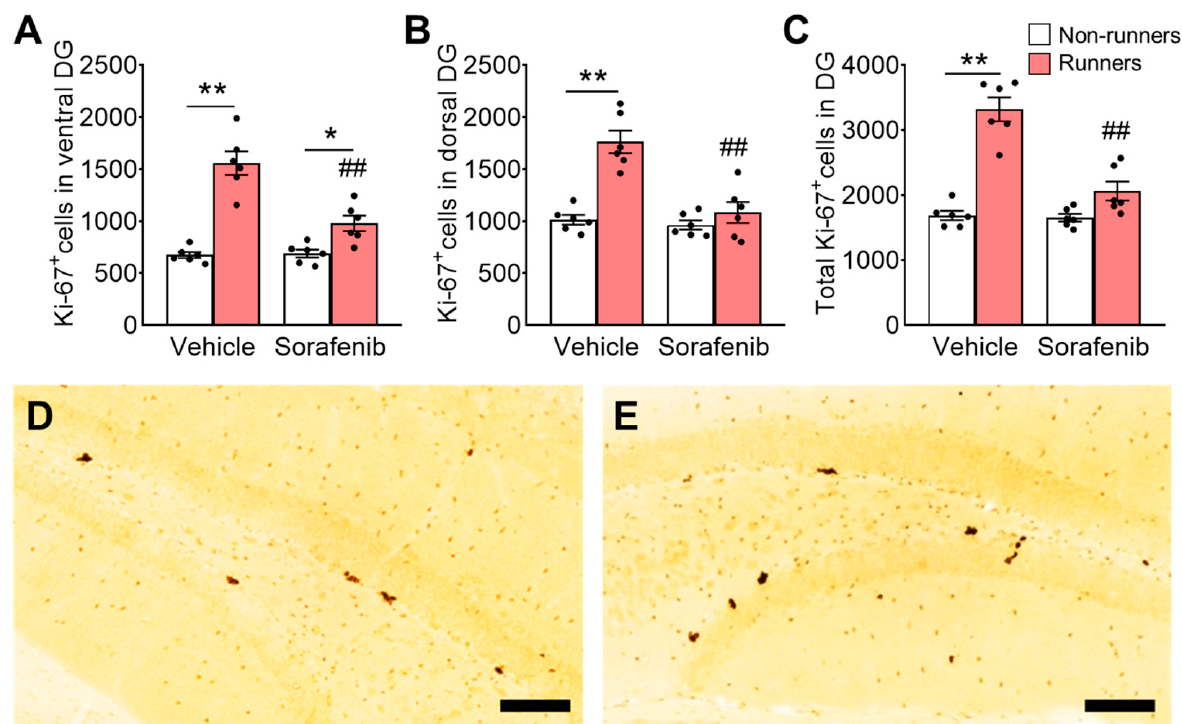
Figure 4. Voluntary running failed to increase cell proliferation in DG of sorafenib-treated mice. ( A ) Voluntary running exercise increased proliferating progenitors in the ventral DG of vehicle-treated mice (Tukey’s post hoc: ** p < 0.005 vs. Vehicle + Non-runners). Sorafenib did not affect the proliferating progenitor number. Although voluntary exercise increased the proliferating cell counts in sorafenib-treated mice (Tukey’s post hoc: * p < 0.05 vs. Sorafenib + Non-runners), the exercise-induced proliferation was significantly lower (Tukey’s post hoc: ## p < 0.005 vs. Sorafenib + Non-runners) in the ventral DG. ( B , C ) Similarly, concomitant voluntary exercise promoted cell proliferation in the ( B ) dorsal and ( C ) whole DG in vehicle-treated runners (Tukey’s post hoc: ** p < 0.005 vs. Vehicle + Non-runners), but not in sorafenib treated mice (Tukey’s post hoc: ## p < 0.005 vs. Vehicle + Runners). ( D , E ) Representative images of Ki-67 positive cells in the ( D ) ventral and ( E ) dorsal DG (Scale bars, 100 μ m in 200×). Results were expressed as mean ± SEM. n = 6 per group. On the other hand, sorafenib treatment did not affect the number of immature neurons (DCX + cells) in the DG (Figure 5A,D; ventral: F 1,20 = 0.3896, p = 0.5396; Figure 5B,E; dorsal: F 1,20 = 0.28, p = 0.6022; Figure 5C; whole DG: F 1,20 = 0.31, p = 0.5808). Voluntary exercise significantly increased the numbers of immature neurons (Figure 5A; ventral: F 1,20 = 81.09, p < 0.0001; Figure 5B; dorsal: F 1,20 = 74.08, p < 0.0001; and Figure 5C; whole: F 1,20 = 100.1, p < 0.0001). The ANOVA residuals in the immature neuron cell counts were normally distributed (Figure 5A; ventral: W = 0.98, p = 0.85; Figure 5B; dorsal: W = 0.94, p = 0.2002; and Figure 5C; whole: W = 0.98, p = 0.82). Tukey’s post-hoc test showed that voluntary running increased the number of immature neurons in both vehicle-treated (Figure 5A; ventral: p < 0.0001; Figure 5B; dorsal: p < 0.0001; and Figure 5C; whole DG: p < 0.01 vs. Vehicle + Non-runners) and sorafenib-treated mice (Figure 5A; ventral: p < 0.0001; Figure 5B; dorsal: p < 0.0001; and Figure 5C; whole DG: p < 0.01 vs. Sorafenib +